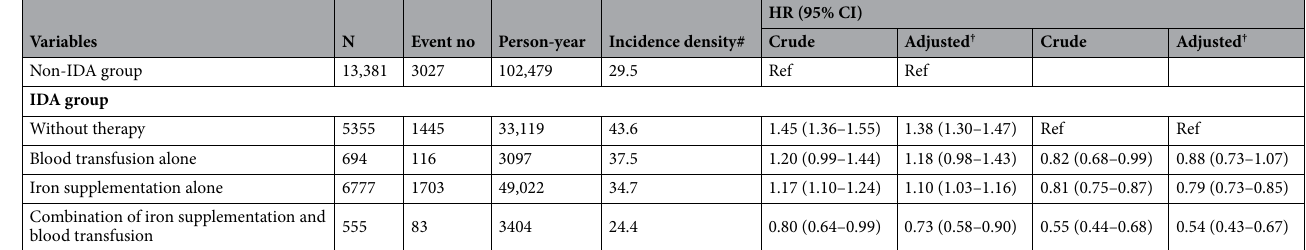
Table 4. Incidence density and hazard ratios of fibromyalgia for iron deficiency anemia status combined with therapy (including iron supplementation and blood transfusion). IDA iron deficiency anemia, HR hazard ratio, CI confidence interval. # Per 1000 person-years. † Model adjusted for sex, age, and each comorbidity (including diabetes, obesity, osteoarthritis, sleep disorder, irritable bowel syndrome, migraine, TMJ, depression, and